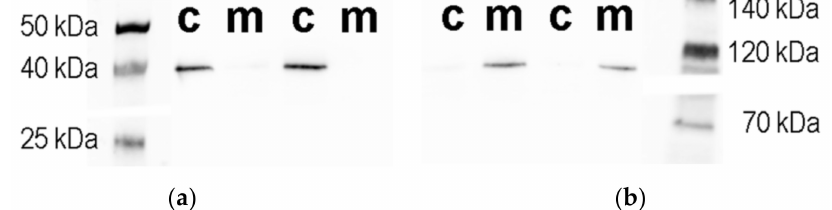
Figure 3. Representative western blot images for ( a ) glyceraldehyde 3-phosphate dehydrogenase or ( b ) α -ketoglutarate dehydrogenase. Abbreviations: c—cytosol fraction; m—mitochondrial